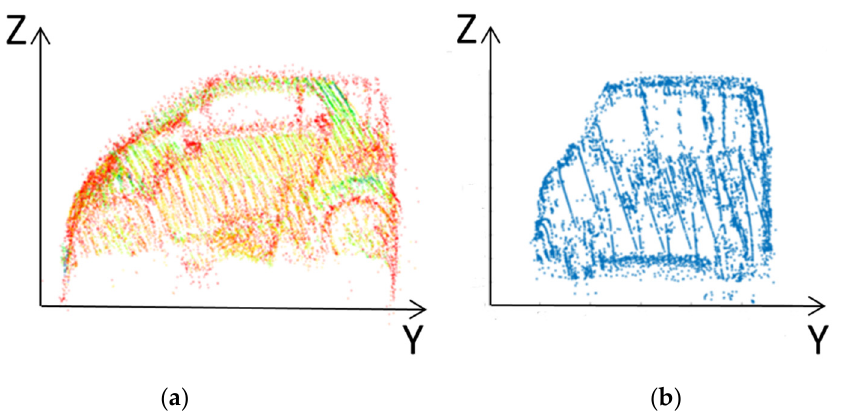
Figure 6. Side projection profile of a vehicle on YOZ plane. Note: based on original collected points ( a ); based on selected feature points of the vehicle ( b ). (Red, green: different reflectance values of point clouds).